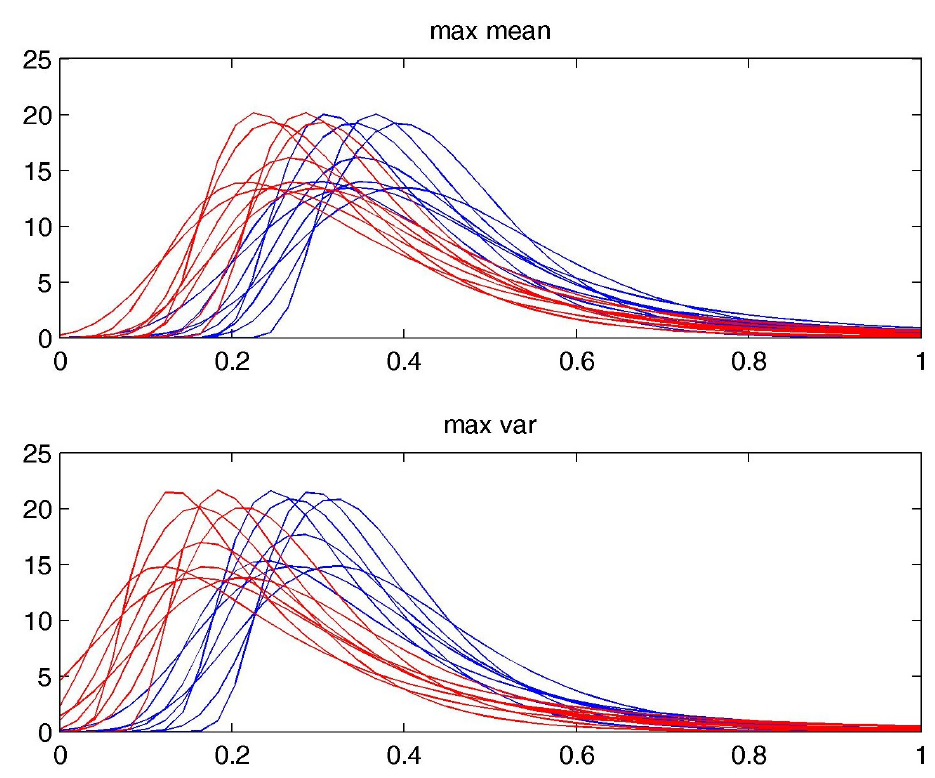
Figure 7. Distributions for parameters ξ , σ , and µ and all combinations of parameters ξ ± and µ ± , as given in Table 3. Blue (red) curves show the experimental (NCEP) 95%